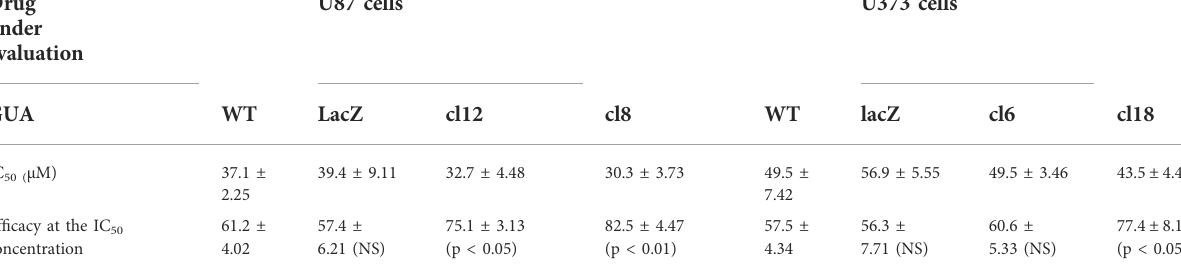
TABLE 1 Inhibitory growth effect caused by GUA in U87 or U373 cell lines, wild type (WT) or overexpressing GPR23 receptor (U87 clones 12 and 8; U373 clones 6 and 18) or lacZ control vector. Drug under